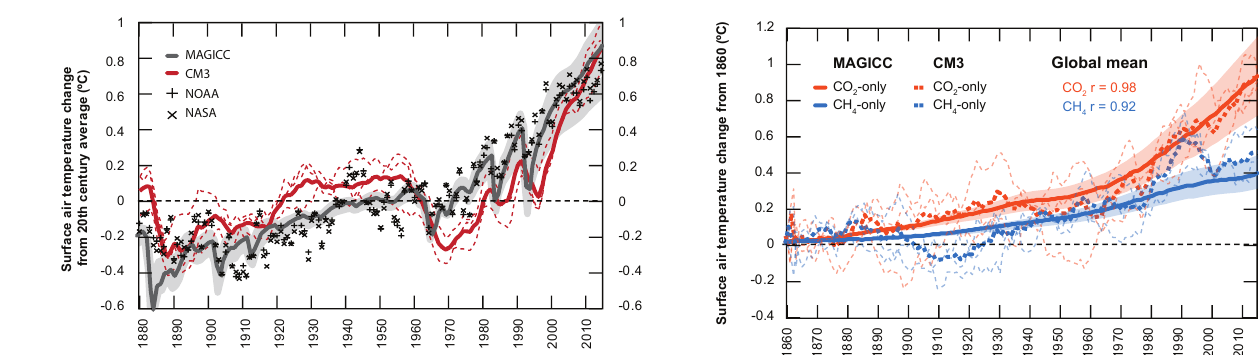
Figure 6. Global mean surface air temperature responses in de- grees Celsius ( ◦ C) for CM3 (dashed line) and MAGICC (solid line) model-derived simulations – CO 2 -only (orange) and methane-only (blue). Individual initial condition-driven ensemble members for CM3 runs shown in thin dashed lines. Range for MAGICC physics- driven ensemble members shown in shaded colours. CM3 data are 5-year running means. Correlation coefficient between MAGICC and CM3 temperature responses are also